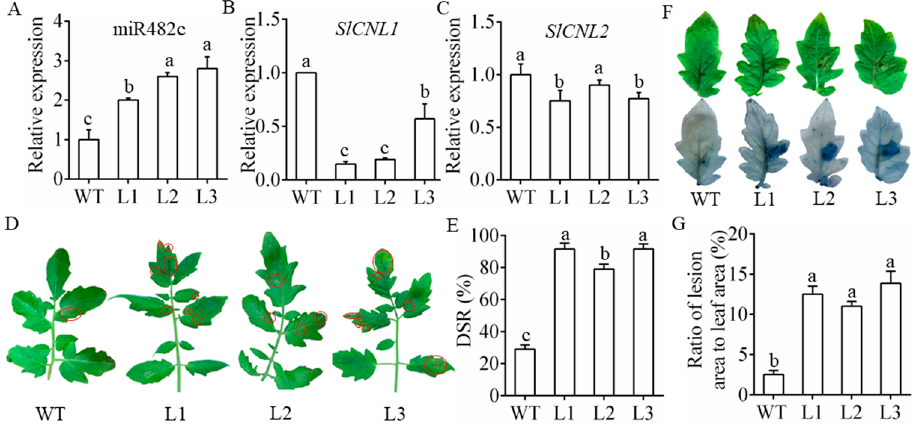
Figure 3. Disease resistance of transgenic plants stably overexpressing miR482c. ( A , B , C ) The relative expression levels of miR482c ( A ), SlCNL1 ( B ), and SlCNL2 ( C ) in transgenic tomato lines. WT: wide type; L1: line 1; L2: line 2; L3: line 3. ( D ) The disease symptoms of WT and L1–L3 in the whole-plant infection assay on the 5th day after infection. ( E ) The disease severity rating (DSR) of WT and L1–L3 on the 5th day after infection. ( F ) Necrotic areas on detached leaves of the WT and L1–L3 plants on the 5th day after inoculation. Top: necrotic areas; bottom: trypan blue staining of the detached leaves. ( G ) The ratio of lesion area to leaf area in the detached-leaf infection assay. SDs of three replicates were displayed by error bars. The letters above the column indicate a significant difference ( p < 0.05) between the samples.